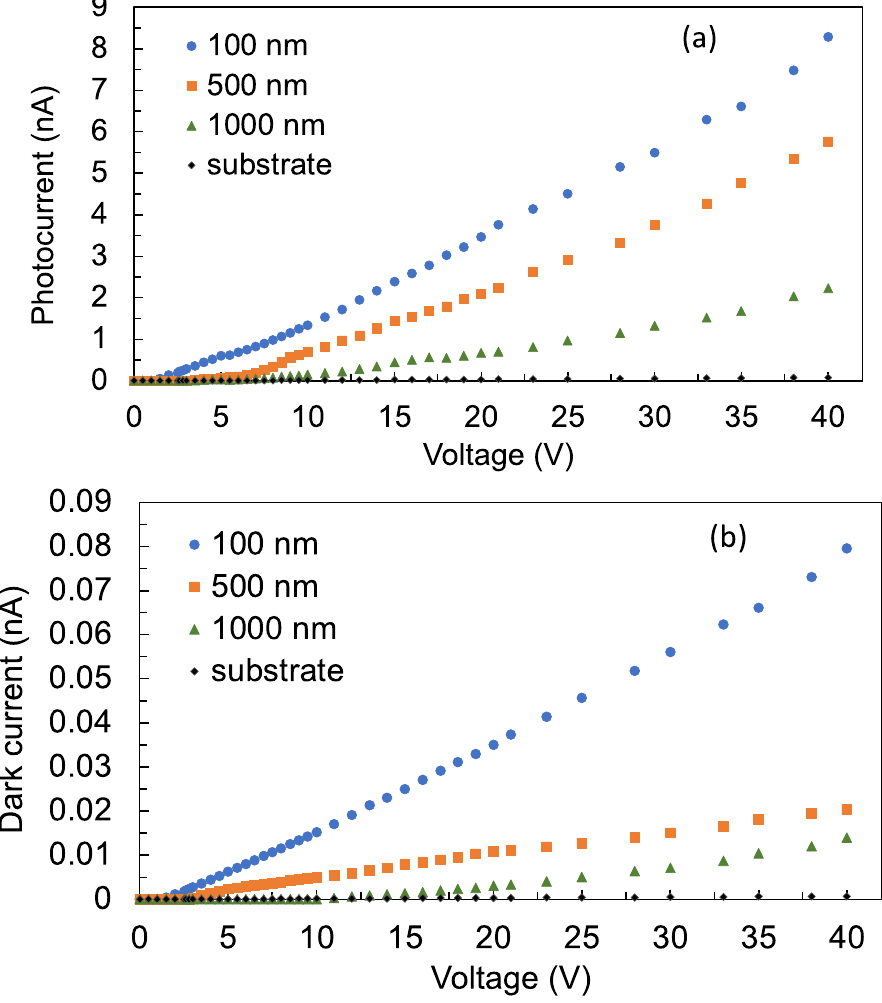
Figure 5. I-V characteristics of the detectors with 100 nm, 500 nm, and 1000 nm film thicknesses ( a ) under 260 nm UV-C illumination and ( b ) under darkness when the light source is turned off.